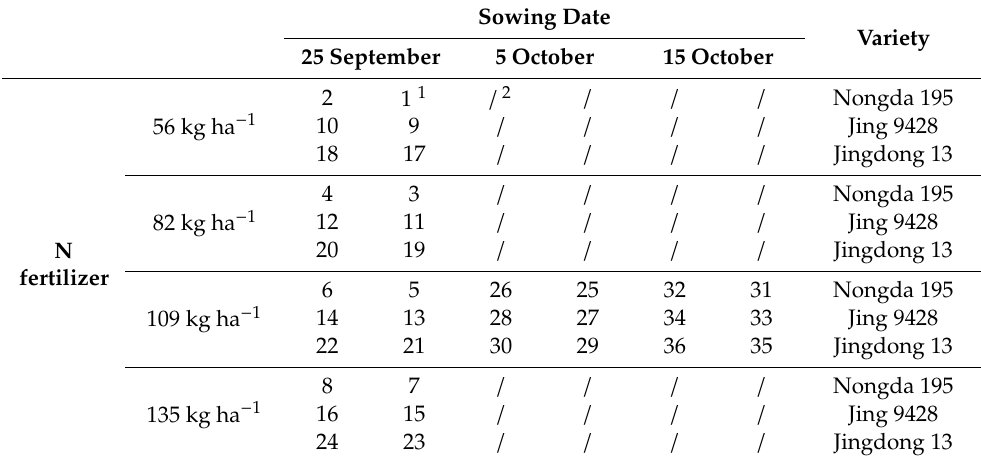
Table 2. Descriptions of the winter wheat experimental design in